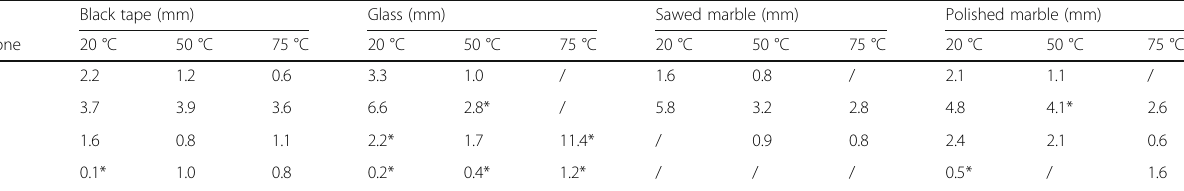
Table 2 Measurements carried out in the four zones of the droplets. Average values from six droplets with at least three measurements for zone and droplet Black tape (mm) Glass (mm) Sawed marble (mm) Polished marble